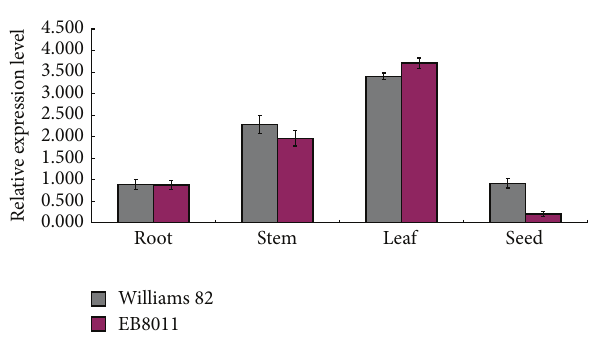
Figure 5: qRT-PCR analysis of GmFad2-1b in the different tissue. RNA was extracted from root, steam, leaf, and early flowering seed. The abundance of GmFad2-1b transcripts was normalized to that of Actin